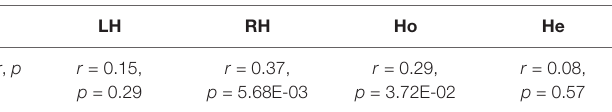
TABLE 2 | The correlation of the four networks for the improvement of motor function after DBS